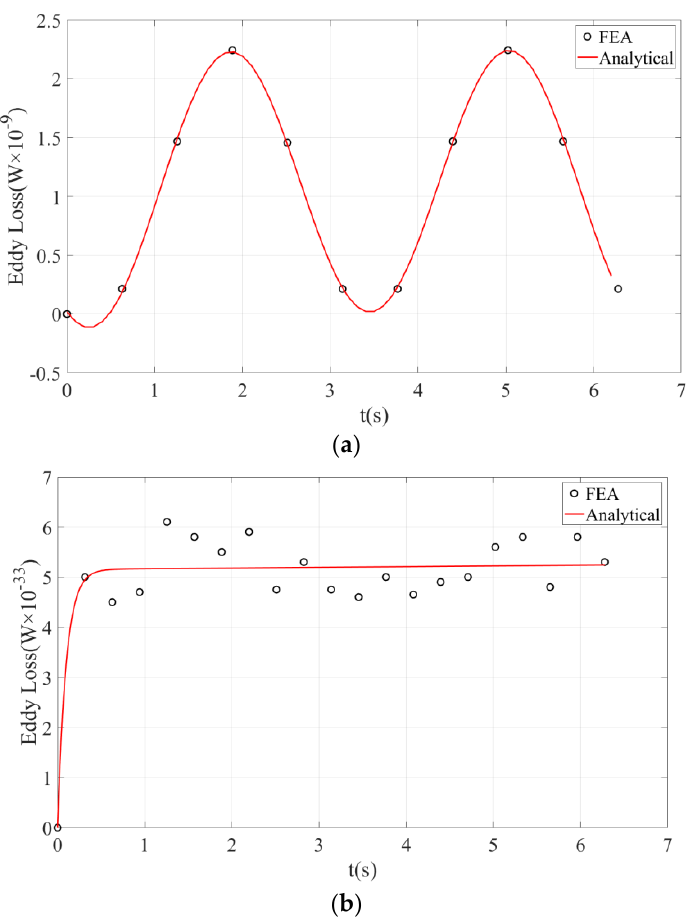
Figure 3. Eddy current loss produced by two kinds of stator coils. ( a ) Eddy current produced by middle stator coil and ( b ) eddy current produced by upper and lower stator coils.